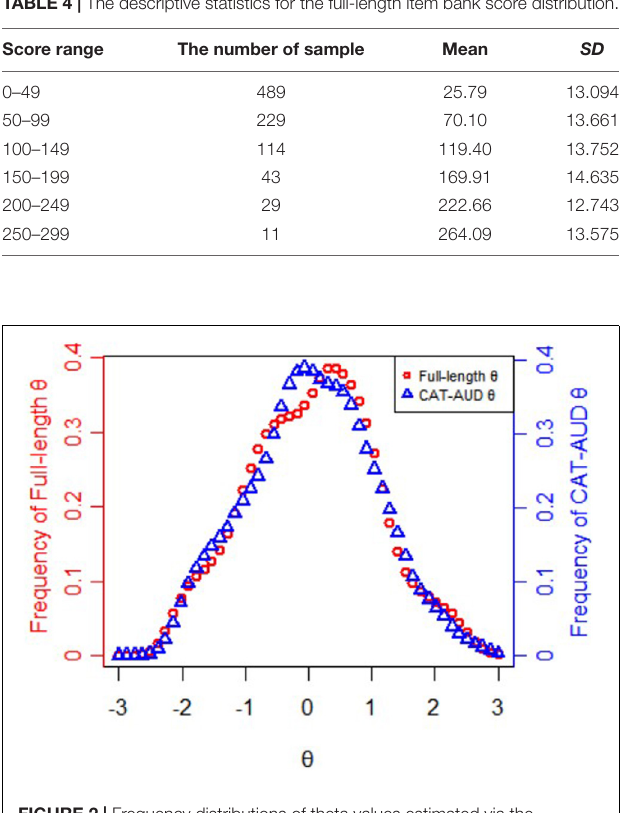
FIGURE 2 | Frequency distributions of theta values estimated via the full-length item bank and the CAT-AUD at a given SE level (SE ≤ 0.32).